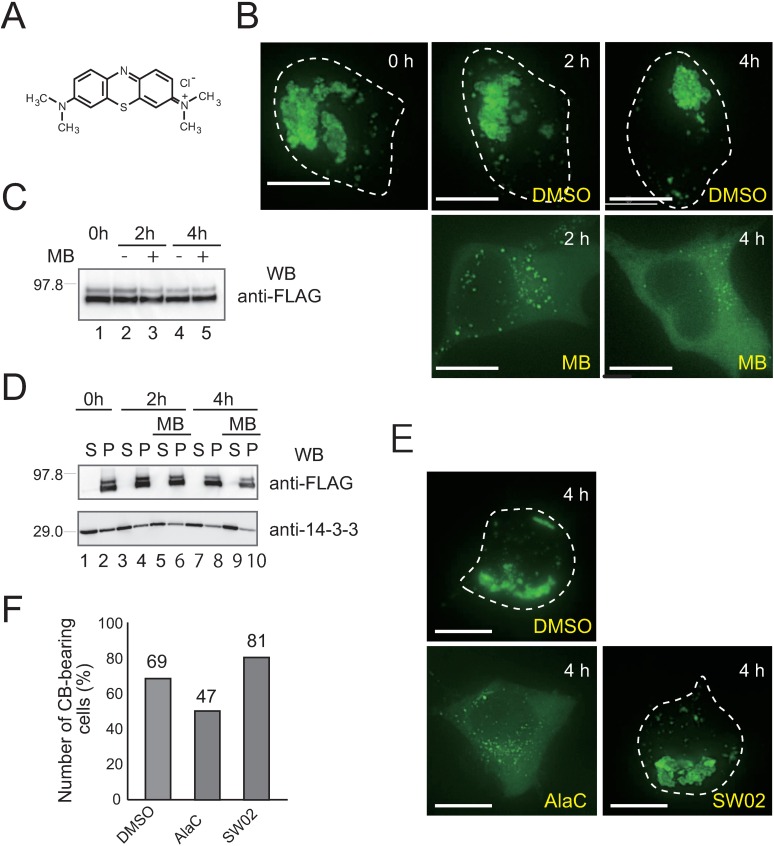
Methylene blue (MB) disrupts the structure of TRIM32-containing CBs in HEK293 cells.(A) MB chemical structure. (B) Fluorescence microscopy images of HEK293 cells with preformed TRIM32 CBs that were exposed to either DMSO or 50 μM MB dissolved in DMSO for 2 and 4 h. (C) FLAG-TRIM32-transfected HEK293 cells with preformed TRIM32 CBs were exposed to 50 μM MB dissolved in DMSO (+) or DMSO only (-) for 2 and 4 h. Whole proteins were extracted with 1% SDS and western-blotted with anti-FLAG to monitor total TRIM32 levels. (D) HEK293 cells with preformed TRIM32 CBs were treated with DMSO and MB, then homogenized in PBS. Western blots of soluble (S) and insoluble (P) proteins with anti-FLAG (upper panel) and anti-PAN 14-3-3 antibodies (lower panel). The cytosolic marker 14-3-3 was used as a loading control for soluble and insoluble fractions. (E) Fluorescence microscopy images of HEK293 cells with preformed TRIM32 CBs that were exposed to DMSO, AlaC (50 μM), or SW02 (50 μM) for 4 h. (F) The percentage (out of ~400 cells) of CB-containing HEK293 cells exposed to DMSO, AlaC or SW02. Bars in (B) and (E), 10 μm.